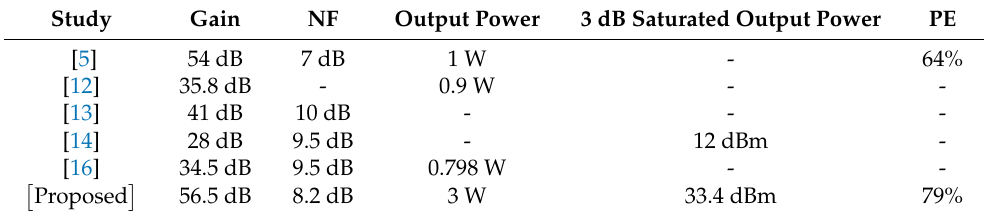
Table 4. Comparison among the results of the proposed work and past studies. Study Gain NF Output Power 3 dB Saturated Output Power PE [5] 54 dB 7 dB 1 W - 64% [12] 35.8 dB - 0.9 W - - [13] 41 dB 10 dB - - - [14] 28 dB 9.5